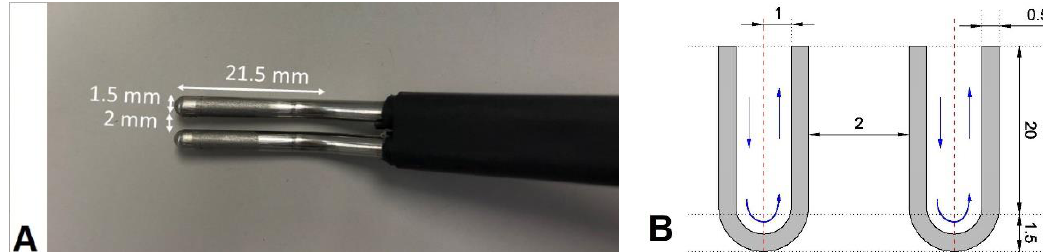
Figure 2. ( A ) Bipolar RF applicator used to consider the geometry of the computational model. ( B ) Scheme of the electrodes’ tips included in the bipolar RF applicator of the left picture (in mm, out of scale).